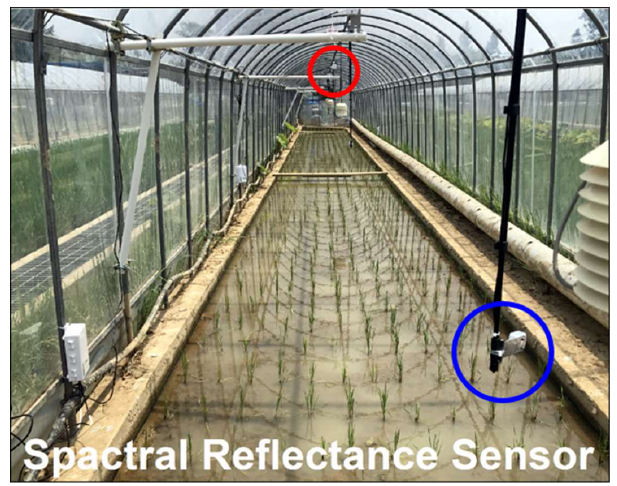
Figure 5. The inside of a temperature gradient field chamber (TGFC). Spectral reflectance sensors (SRS) were mounted on a mono-pod at each position in 2017 and 2018. The blue circle indicates the downward-looking SRS and the red circle indicates the upward-looking SRS.